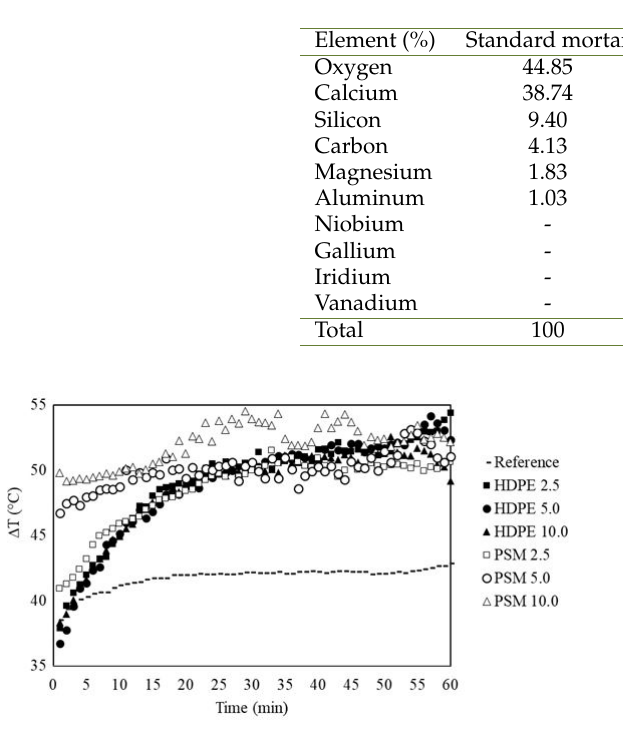
Fig. 7. Different temperature profiles of wall